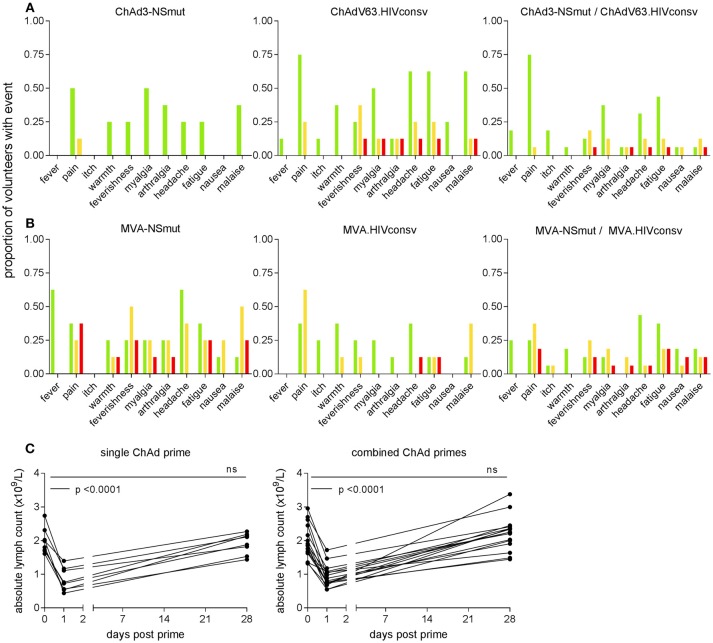
Frequency of local and systemic adverse events recorded by volunteers on diary cards. The proportion of volunteers reporting symptoms at any time during 72 h following (A) ChAd- and (B) MVA-vectored vaccines is shown on the y axis. Color code indicates maximum severity of the reaction reported: green—Grade 1 (mild); yellow—Grade 2 (moderate); red—Grade 3 (severe). (C) Peripheral blood lymphocyte counts were measured on day 1 in 23 subjects (two in Group 1 and five in Group 2, shown as single ChAd prime; 16 in Group 3, combined ChAd primes). Respective lymphocyte counts on days 0 and 28 are shown for comparison. By day 28, counts had returned to baseline values.